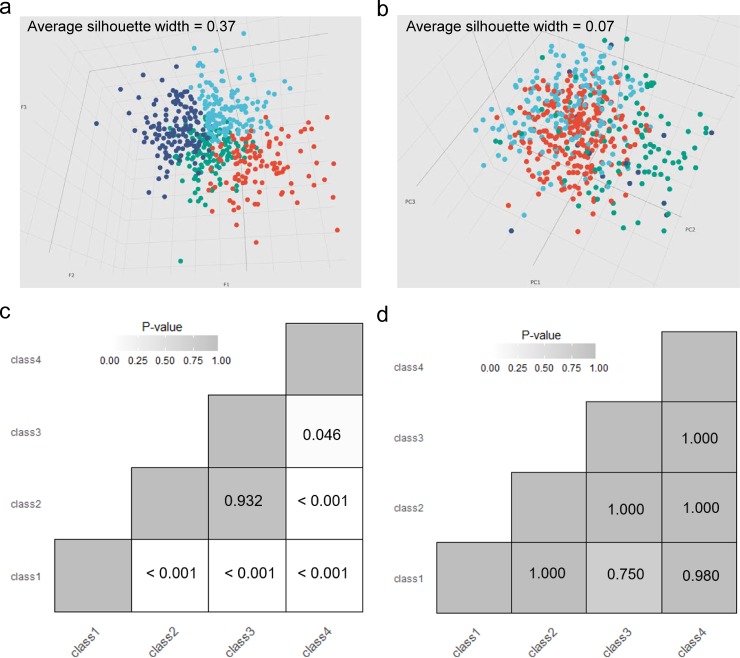
Benchmark of clustering performance in the ovarian cancer subtyping case study.3D visualization revealed patient samples classified to different subtypes were much more tightly distributed in (a) the three-dimensional feature space based on ELM-CC clustering result (average Silhouette width = 0.37) than (b) in the space of top three principal components of gene expression profiles based on Consensus clustering result (average Silhouette width = 0.07). SigClust analysis showed more statistically significant (P < 0.05) pairwise comparisons of subtypes identified based on (c) ELM-CC than (d) the counterpart based on classical consensus clustering method.